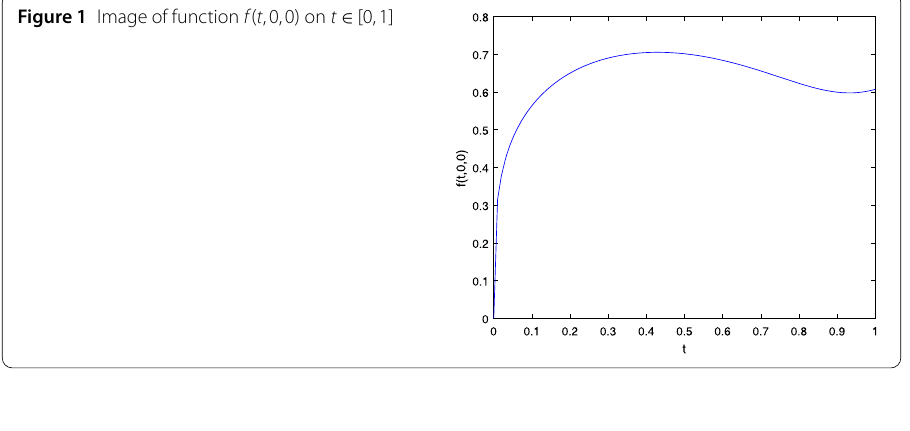
Figure 2 Image of function g ( t ,0,0) on t ∈